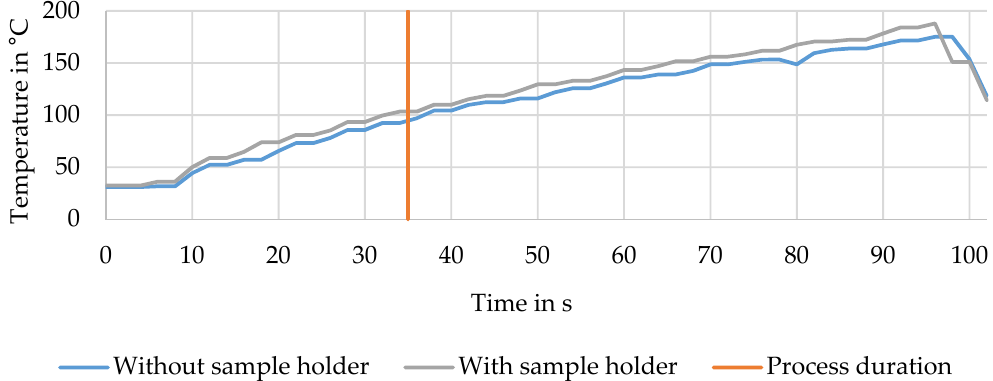
Figure 11. Temperature development underneath a UV radiator with and without the sample holder.